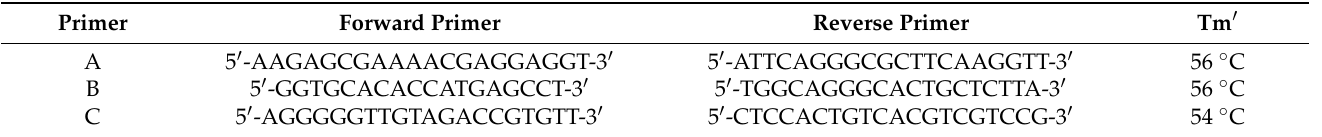
Table 3. The primer names are A, B, and C, respectively. Tm (cid:48) is the representative annealing